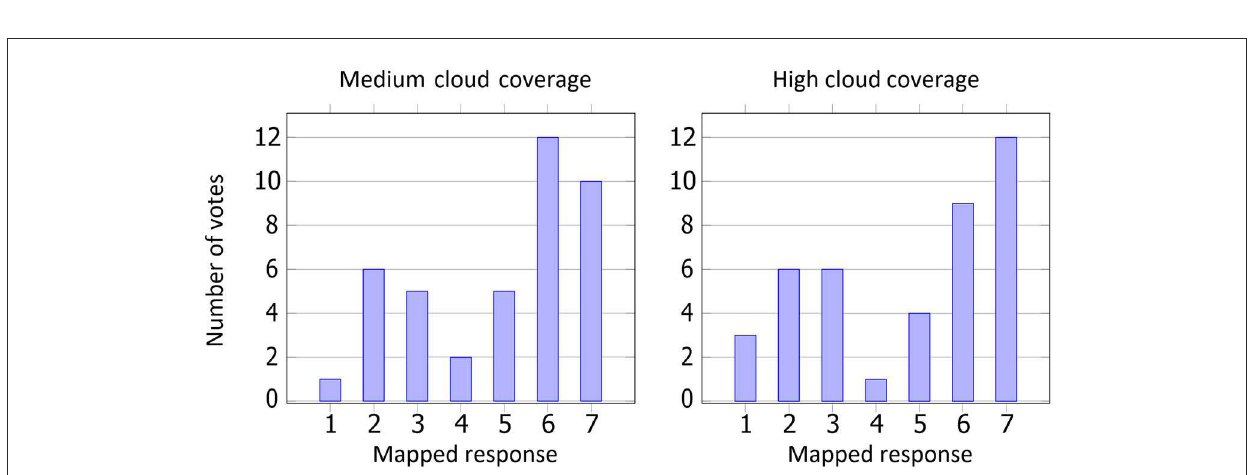
FIGURE14 Number of votes per response option in the questionnaire (response options as given in Section 4.4.1). The two comparisons consisted of two videos each, with (left) medium cloud coverage and (right) high cloud coverage, as shown in Supplementary material.